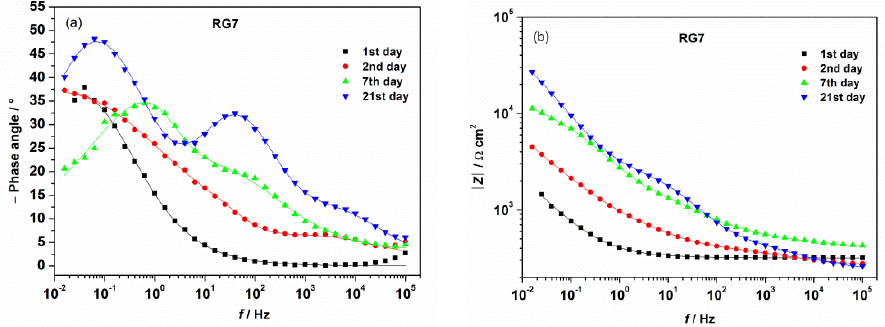
Figure 4. EIS spectra for RG7 for continuous immersion in simulated acid rain at pH 5. ( a ) Bode phase angle; ( b ) Bode impedance.